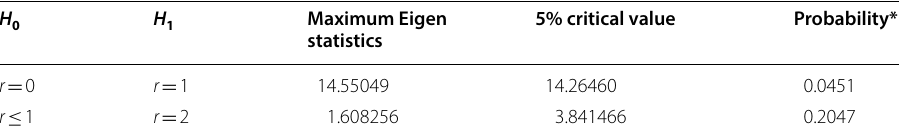
Table 6 Results of Johansen cointegration test (maximum Eigen statistics) for FDI and FT. Source: Calculated by